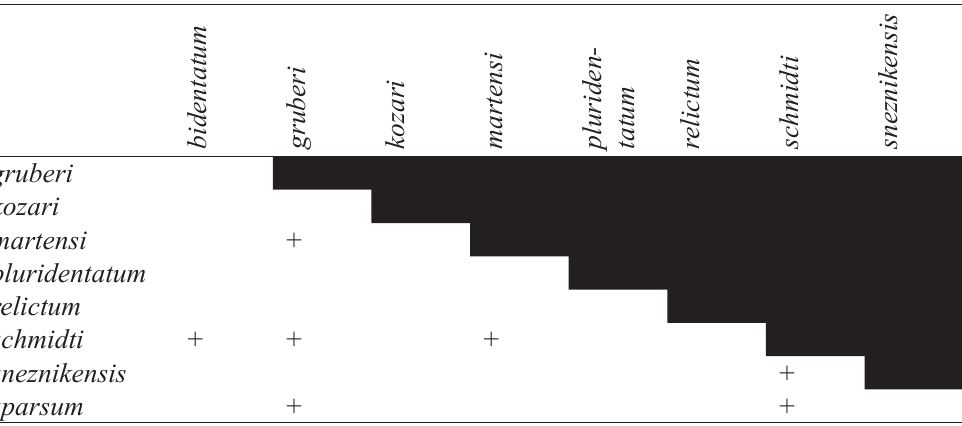
Table 13. Confirmed hybrids among the taxa of the N. bidentatum